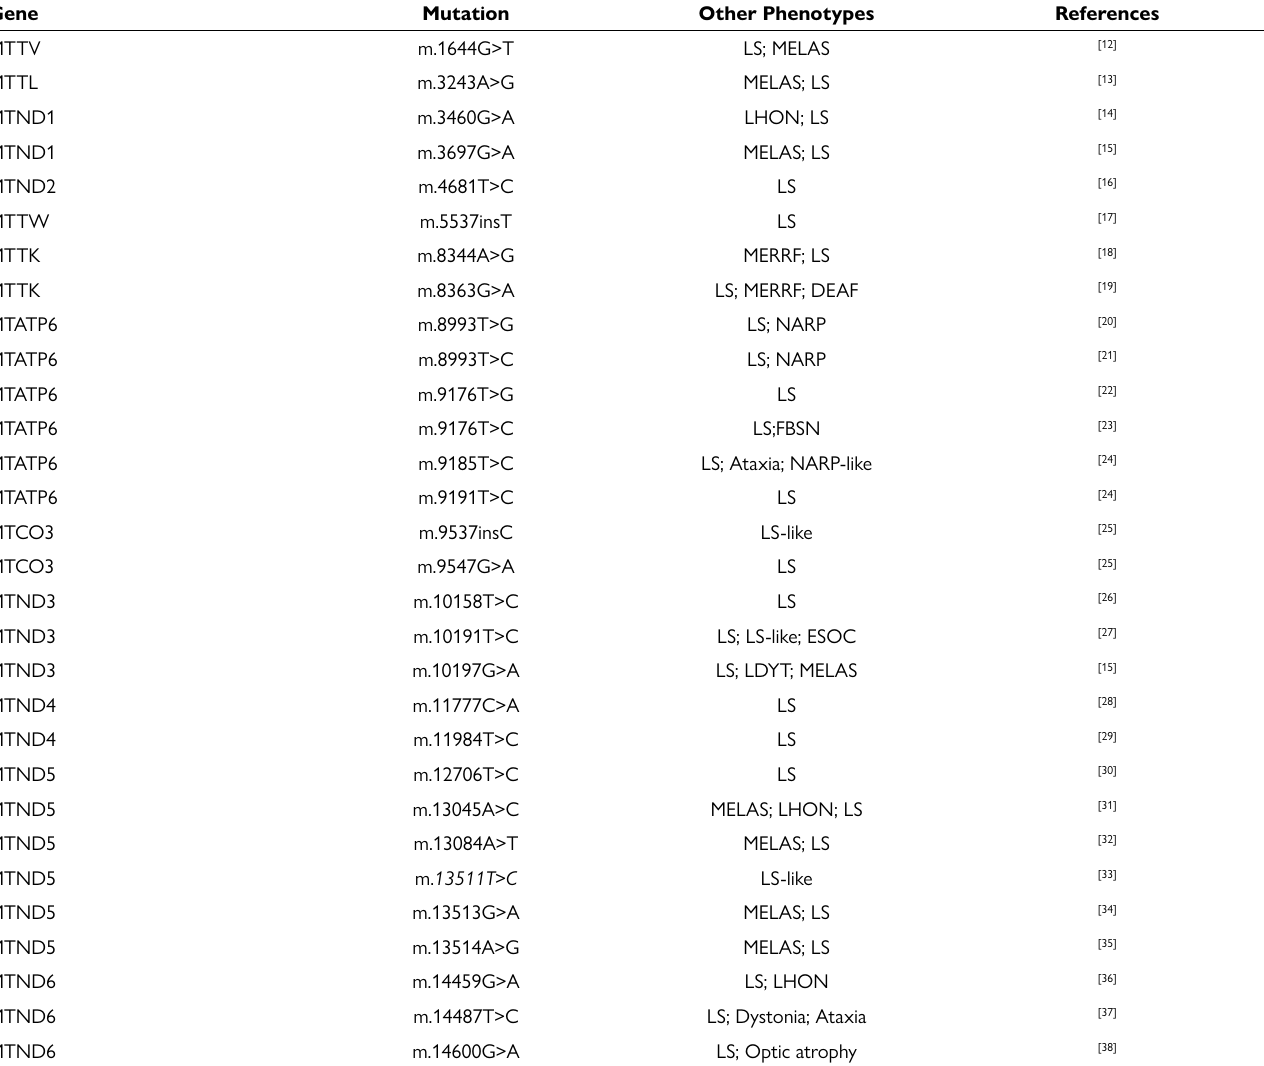
DEAF - Deafness, Sensorineural Hearing Loss; ESOC - Epilepsy, Strokes, Optic atrophy, and Cognitive decline; FBSN - Familial Bilateral Striatal Necrosis; LDYT - Leber Hereditary Optic Neuropathy and Dystonia; LHON - Leber Hereditary Optic Neuropathy; LS - Leigh Syndrome; MELAS - Mitochondrial Encephalomyopathy, Lactic Acidosis and Stroke-Like Episodes; MERRF - Myoclonic Epilepsy and Ragged Red Fiber; NARP - Neurogenic Muscle Weakness, Ataxia, and Retinitis Pigmentosa.